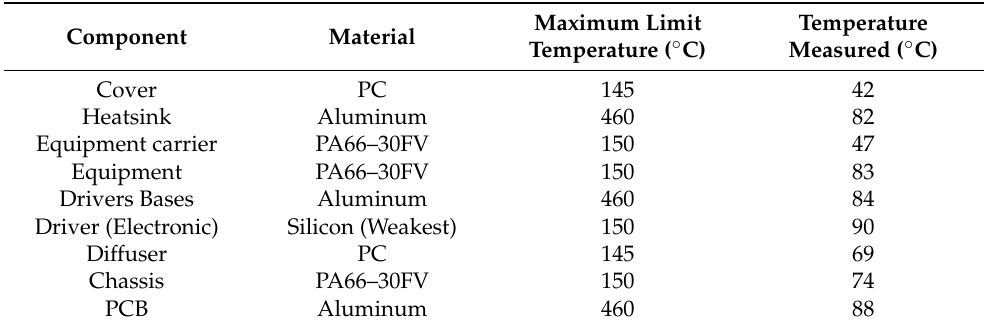
Table 5. Maximum temperature limit of the material versus temperature measured in the different parts of the Model at − 10 ◦ C. Source: our own